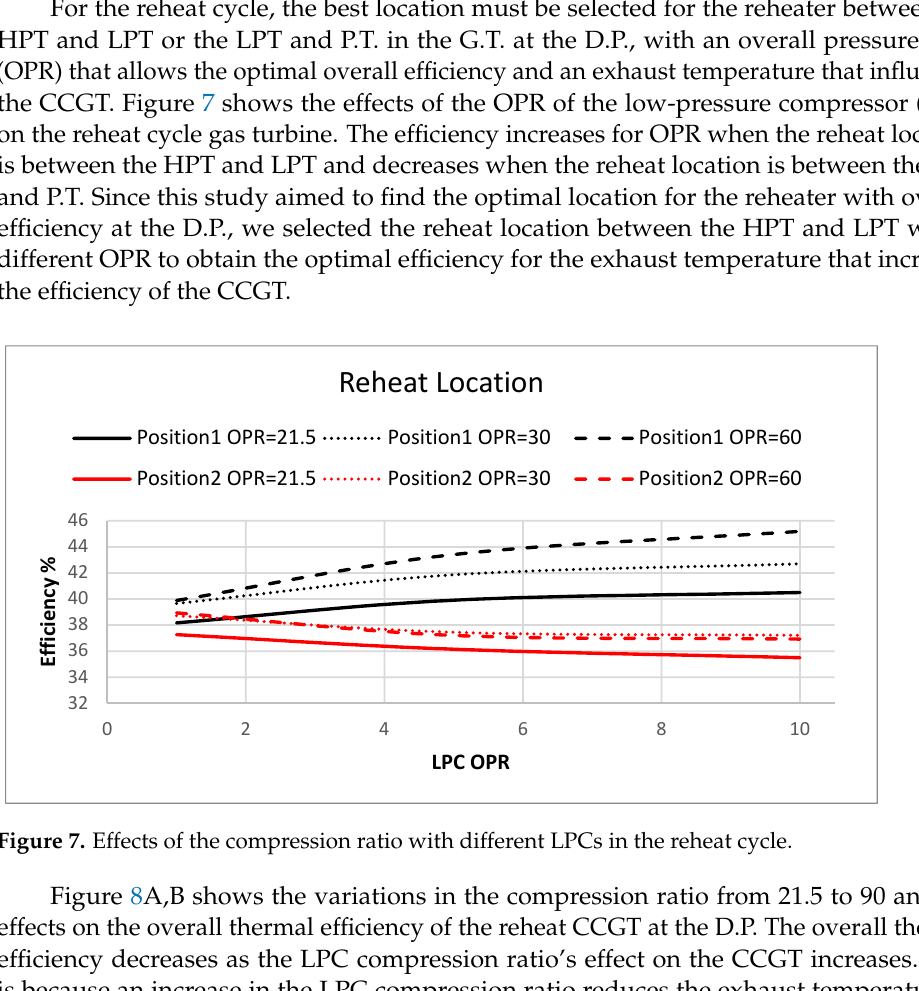
Figure 6. Effects of the compression ratio on the overall thermal efficiency. MDO: marine diesel oil; OPR: overall pressure ratio.